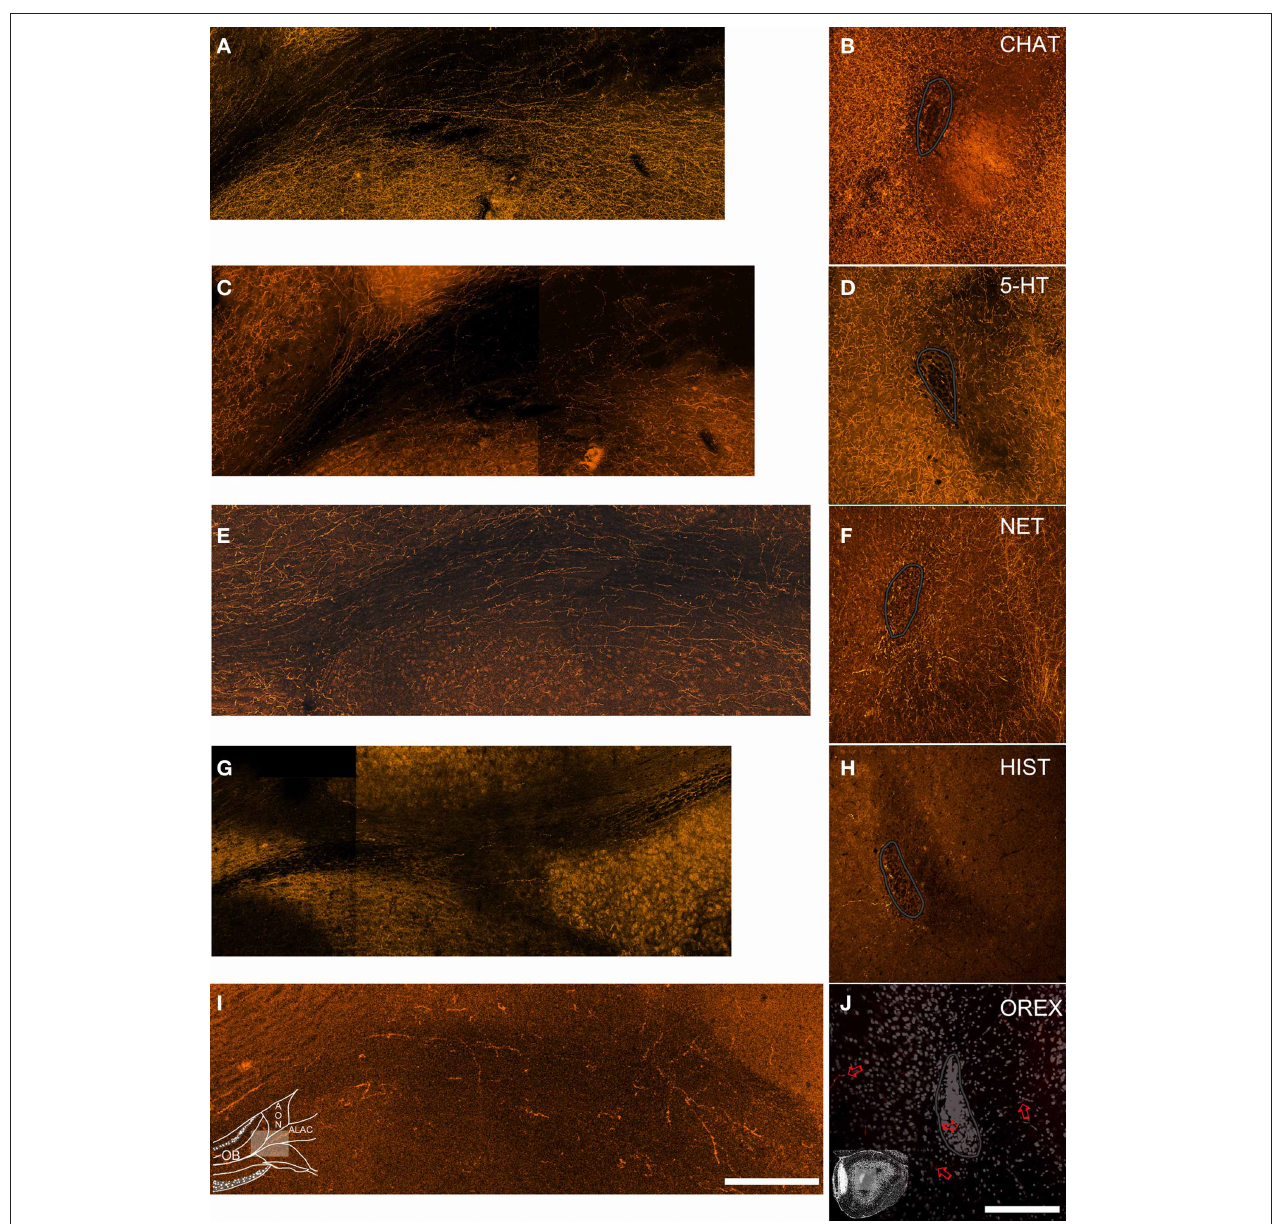
FIGURE 3 | Neuromodulatory fibers appear to enter the olfactory peduncle both through the ALAC and outside of it. Left column: horizontal sections (rostral is to the left and medial to the top) through the olfactory peduncle. Right column: coronal sections (medial to left, dorsal to top) of the peduncle’s core. The SVZ is outlined in gray. Sections were immunostained to visualize cholinergic (A,B) , serotonergic (C,D) , noradrenergic (E,F) , histaminergic (G,H) , and orexinergic fibers (I,J) . Inset